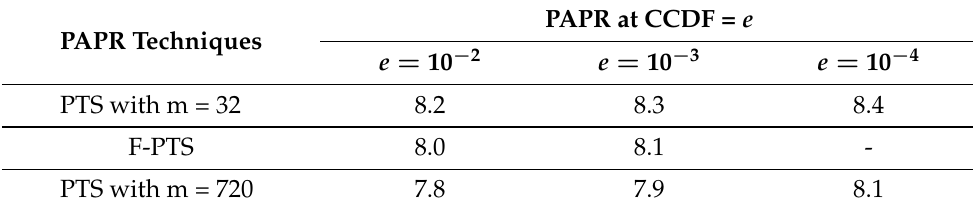
Table 4. PAPR reduction performance of PTS and